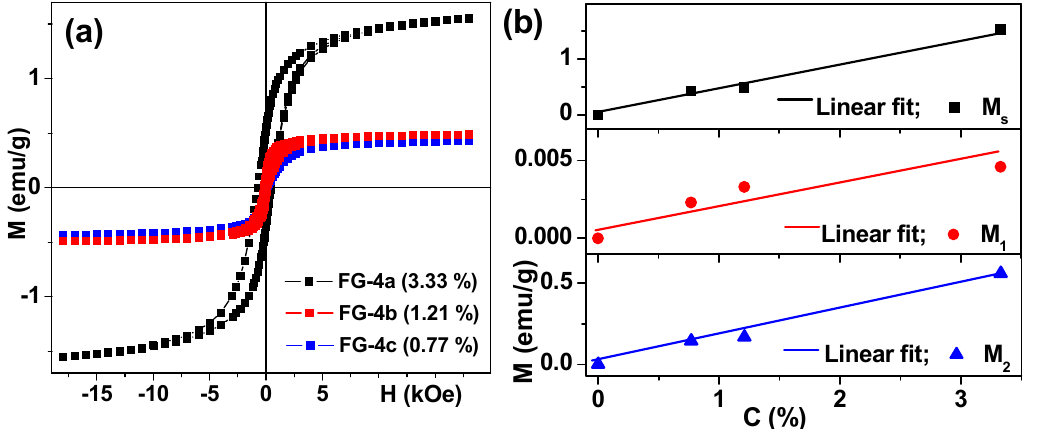
Figure 10. Magnetic properties of ferrogels with strontium hexaferrite particles (see also Table 1). M(H) loops of ferrogels in wide field range in which the saturation tendency for ferrogels is observed ( a ). For FG-4 series the thickener was xanthan gum. Concentration dependence of the saturation magnetization and M 1 , M 2 parameters for FG-4 ferrogels: M 1 (for primary magnetization curve) and M 2 (for approaching remanence) values of the magnetic moments of ferrogels ( b ).